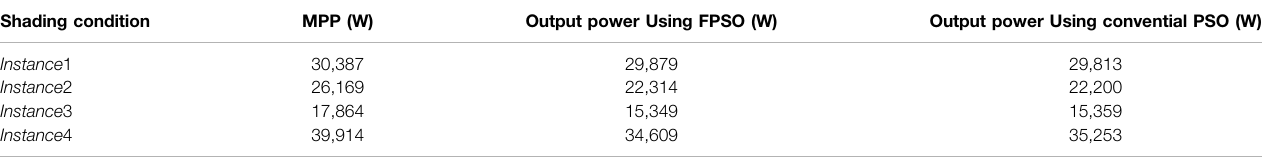
TABLE 6 | Comparison of maximum power point (MPP), output power for fuzzy adaptive PSO (FPSO) and conventional PSO. Shading condition MPP (W)